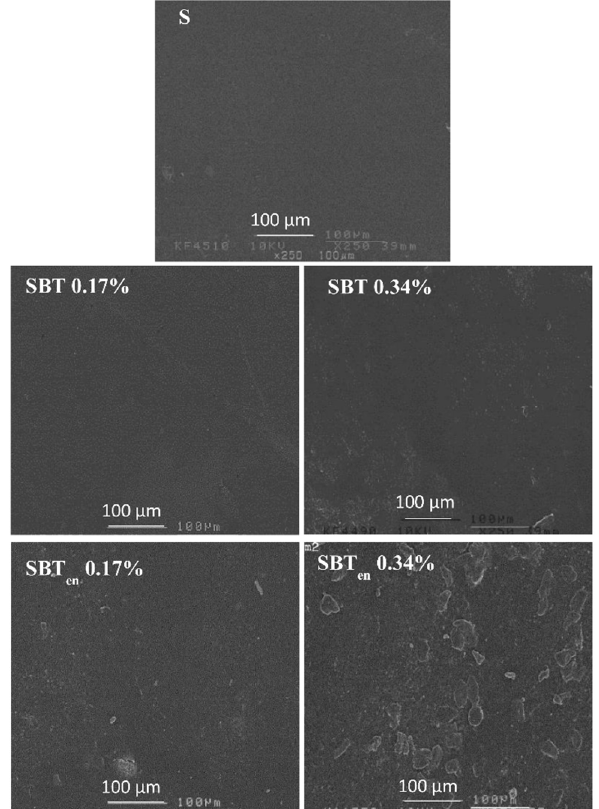
Figure 2. SEM micrographs of the surface of starch films incorporating free or encapsulated SBT extracts: control film (S) and active films incorporating SBT or SBT en at 0.17% or 0.34%.